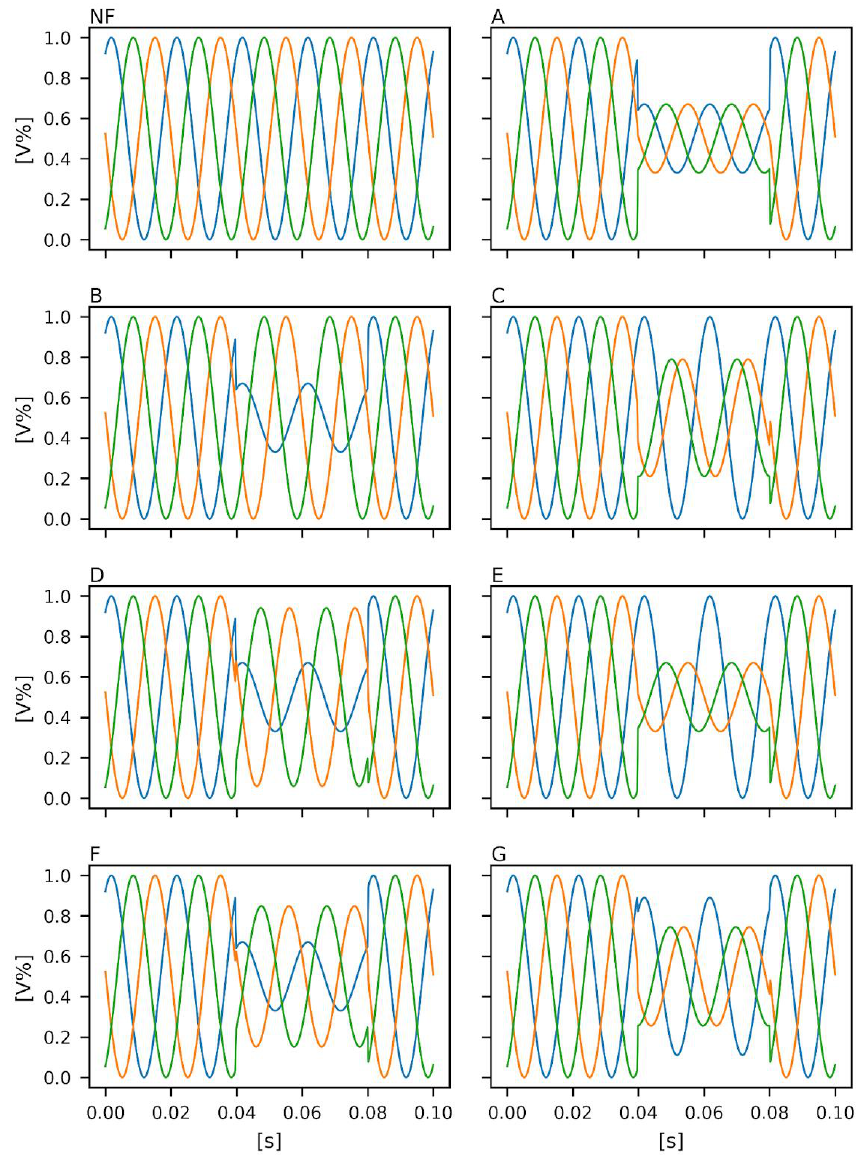
Figure 4. Examples of signals for each class with fault severity being 0.66 for classes other than NF.